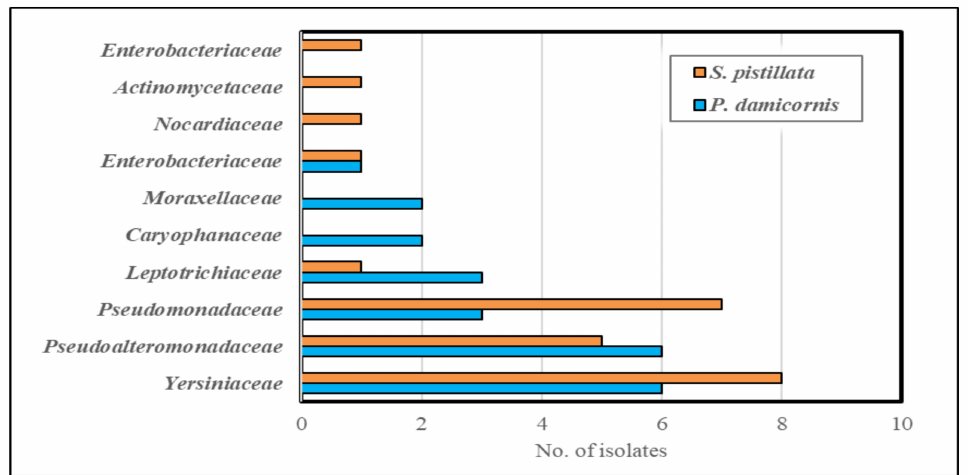
Figure 6. Number of bacterial isolates in seawater surrounding coral based on a biochemical